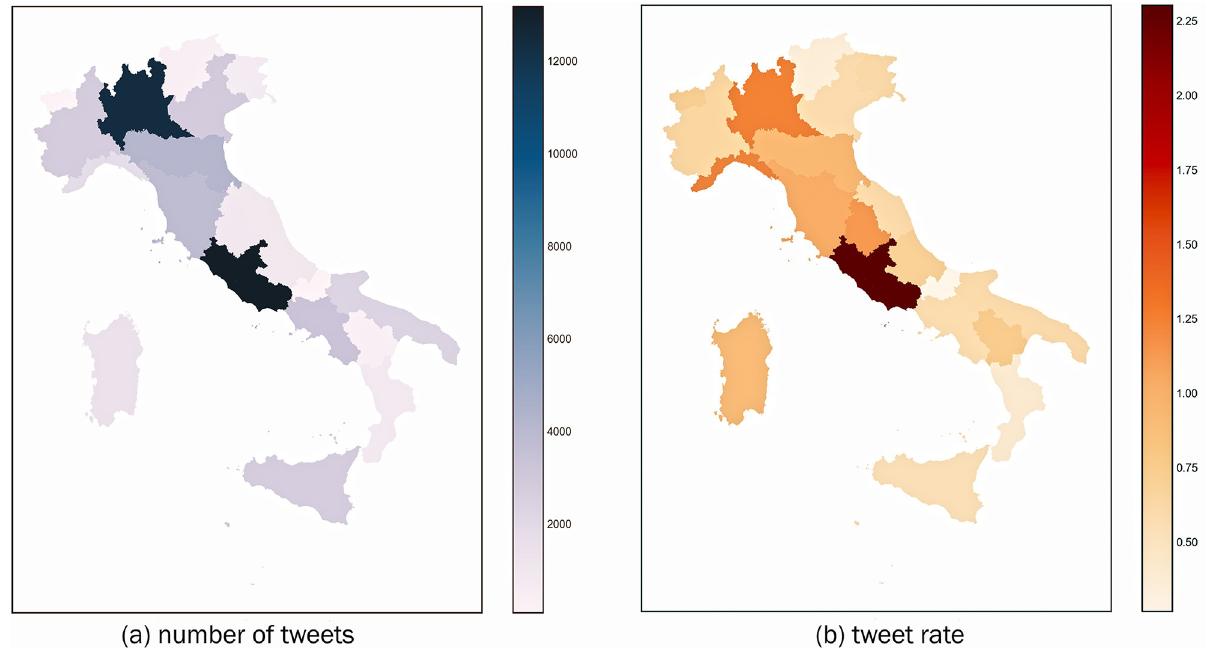
Fig 3. Number of tweets for Italian regions: Absolute values (a) and tweet rate (b).